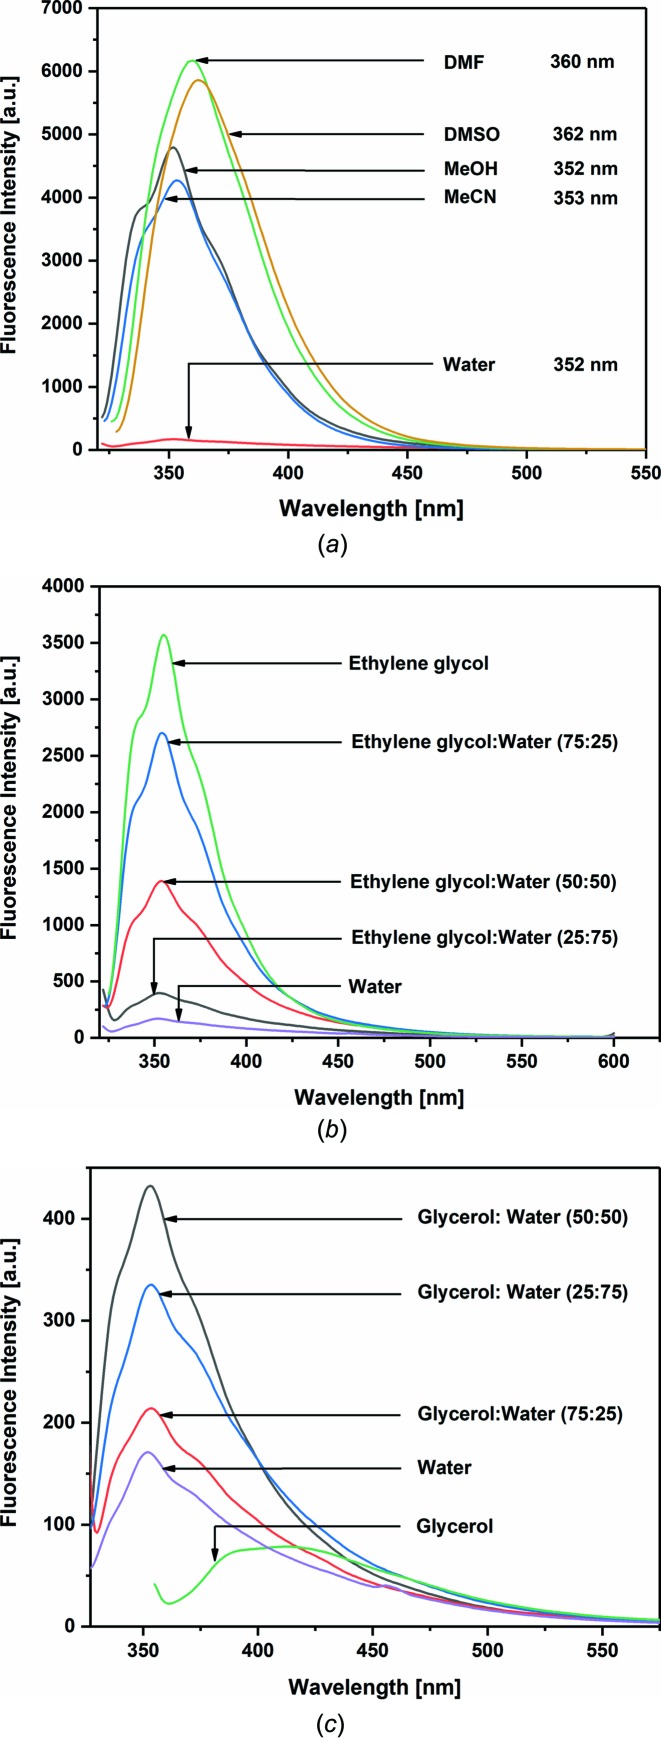
Fluorescence emission spectra of com­pound 3 (1 µM) measured in (a) solvents of different polarity, (b) ethyl­ene glycol and (c) glycerol. Excitation wavelength of nucleoside 3 was 315 nm in ethyl­ene glycol and 345 nm in glycerol.